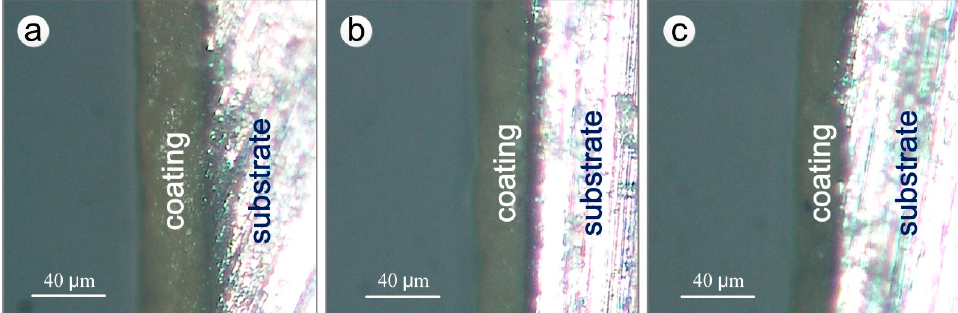
Figure 3. Cross-sections of specimens exposed for different years (one side of the upper surface coatings): ( a ) 7 years; ( b ) 12 years; ( c ) 20 years.